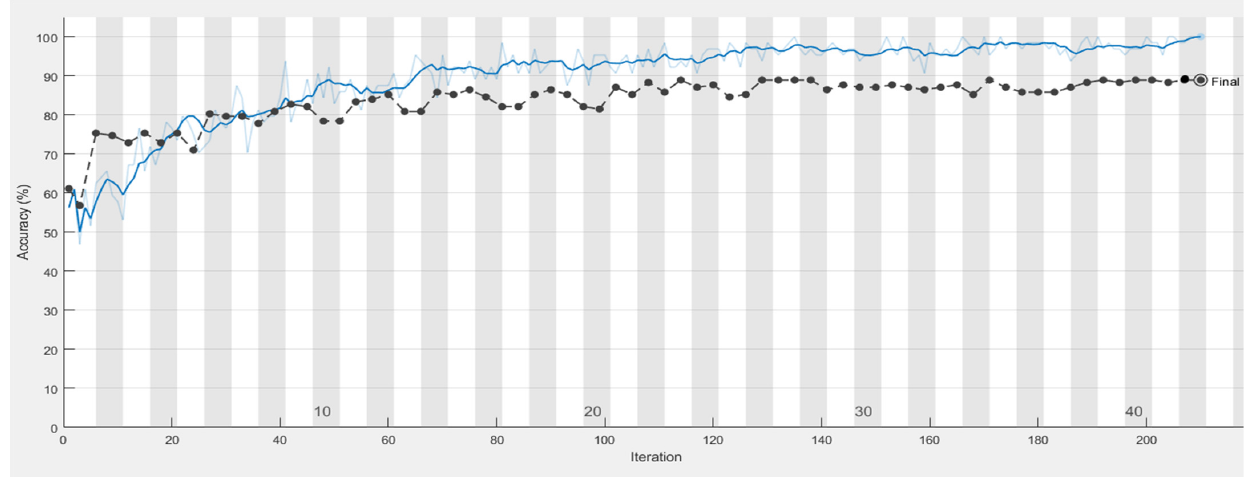
Figure 11. Training process of the model in classifying caries, with the blue line illustrating the accuracy of the training set.